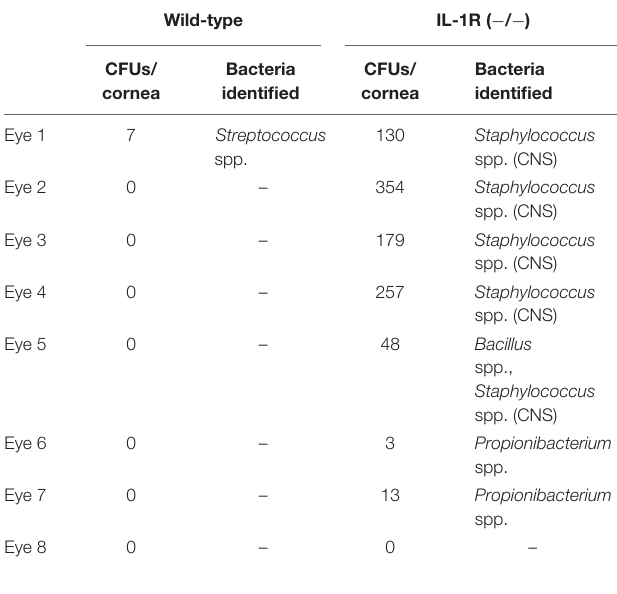
TABLE 1 | Bacteria identified on the corneas of wild-type and IL-1R ( − / − )